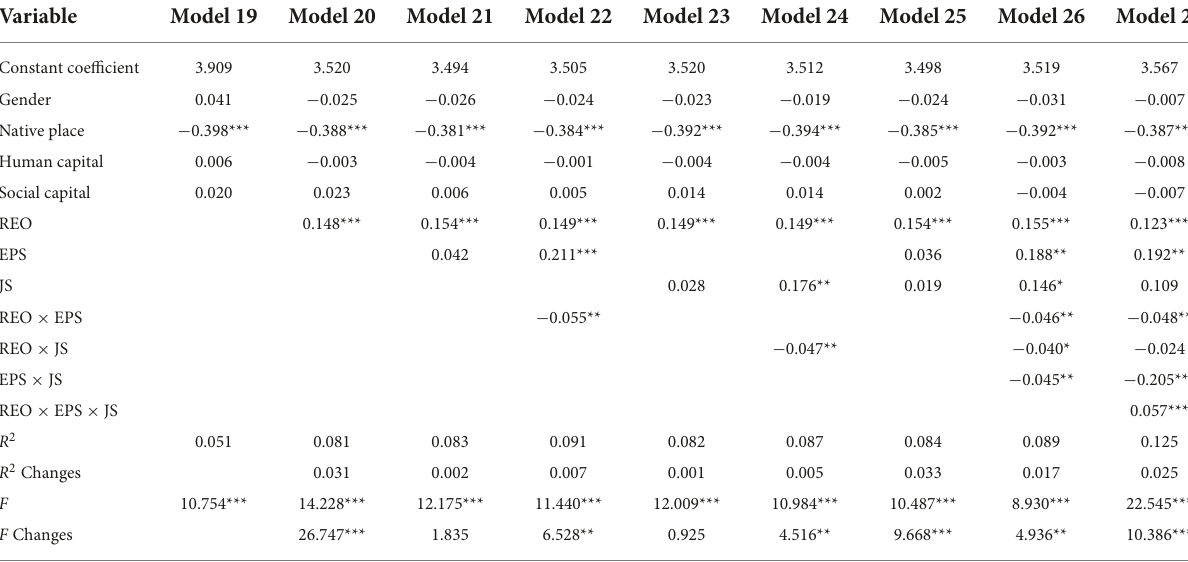
Dependent variable: Family pressure